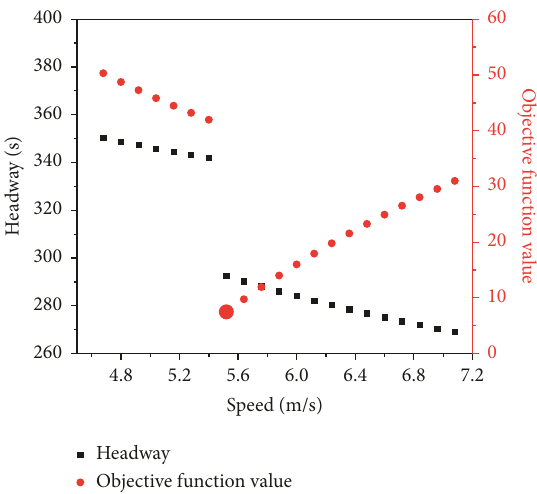
Figure 9: Headways and control objective function values for different adjusted